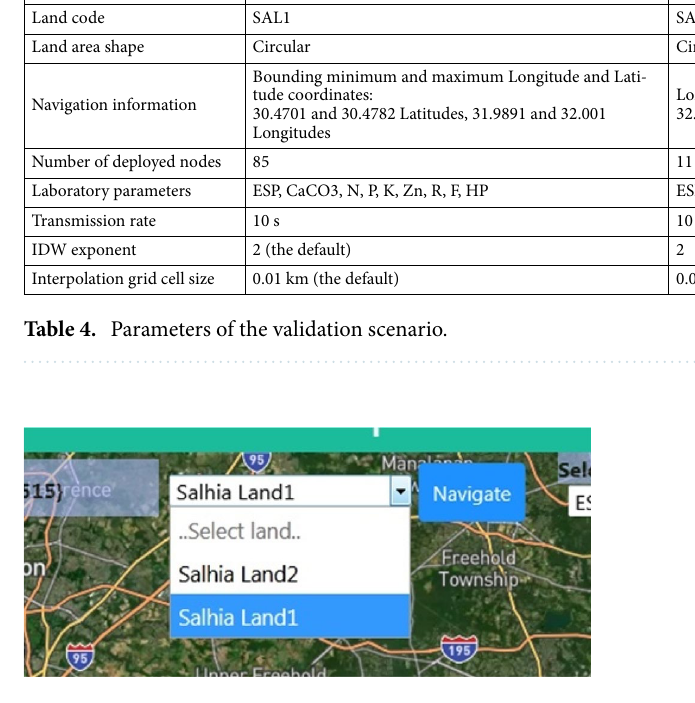
Figure 17. The registered lands list.